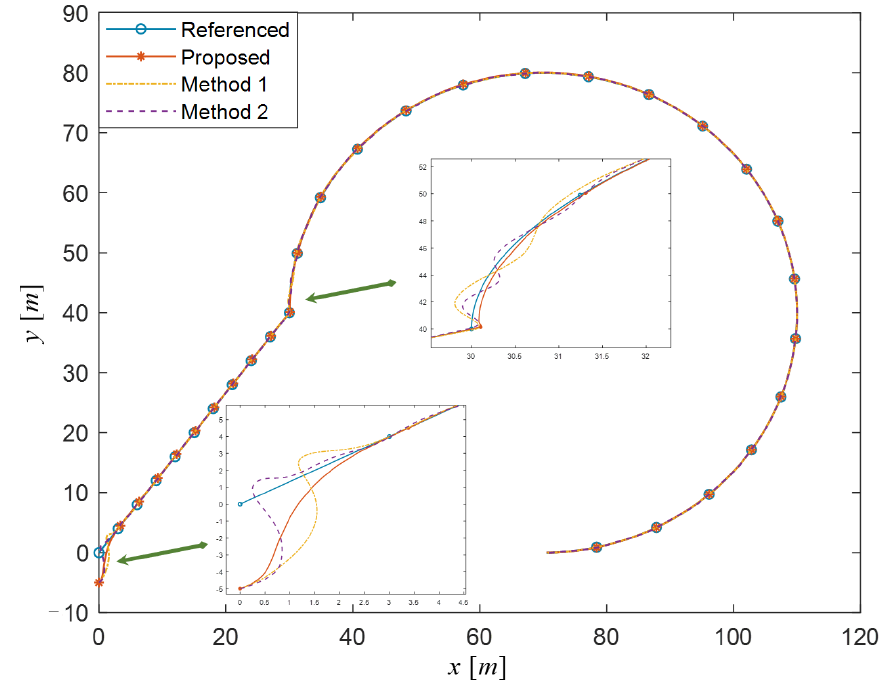
Figure 8. The different methods under the influence of